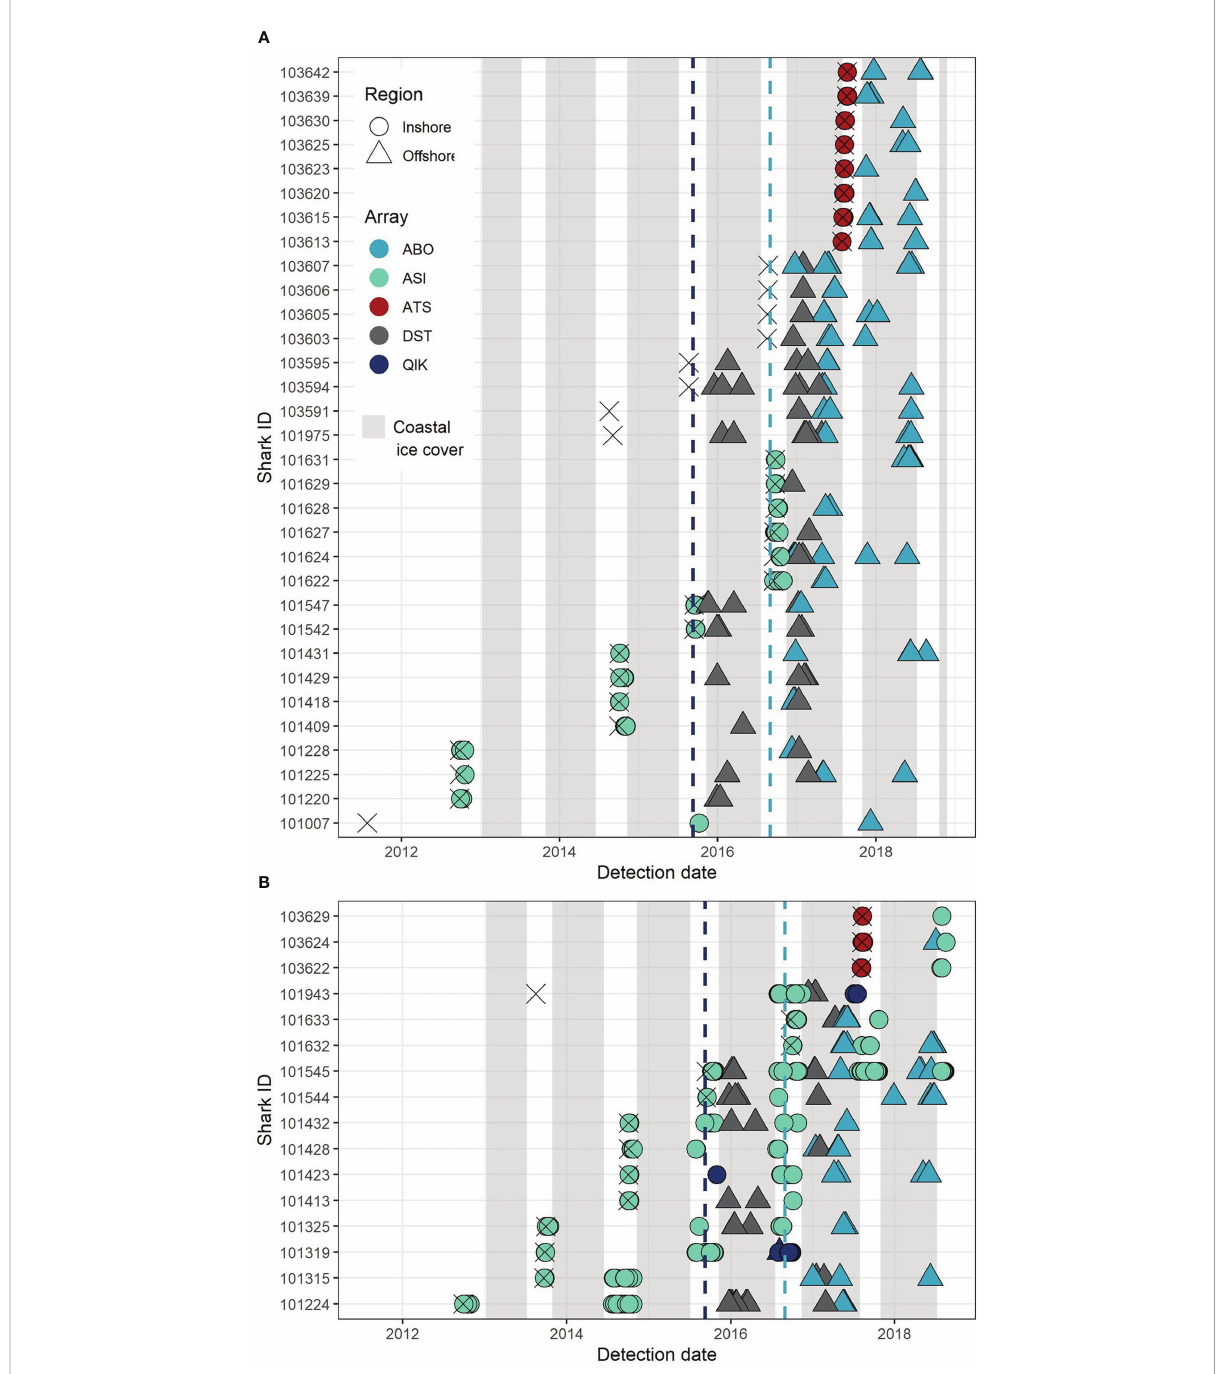
FIGURE 7 Greenland shark detections recorded by acoustic receiver stations in multiple arrays in coastal and offshore Baf fi n Bay, listed by the identi fi cation number of tagged sharks and the time of detection. (A) Sharks that were detected by more than one array but were detected in coastal waters in only one year. (B) Sharks detected by more than one array and in coastal waters over multiple years. Point colour denotes the array on which detections were recorded and point shape indicates the location of the detection as either inshore or offshore. Dashed lines indicate the deployment date of arrays by corresponding colour. The date of tagging and release for each animal is marked by an ‘ X ’ . Shaded bars denote the annual periods of ice cover between the timing of formation (>75% sustained cover) and breakup (<75% sustained cover) in Scott Inlet (Nunavut) throughout the study period (data available at: https://ice-glaces.ec.gc.ca/). [Colour